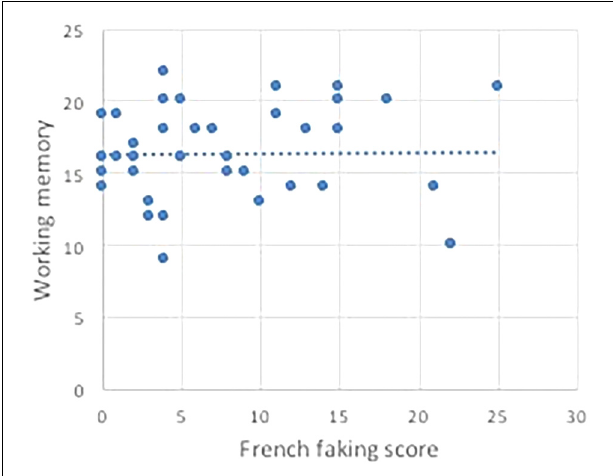
FIGURE 3 | Absence of correlation between the working memory scores and the French faking